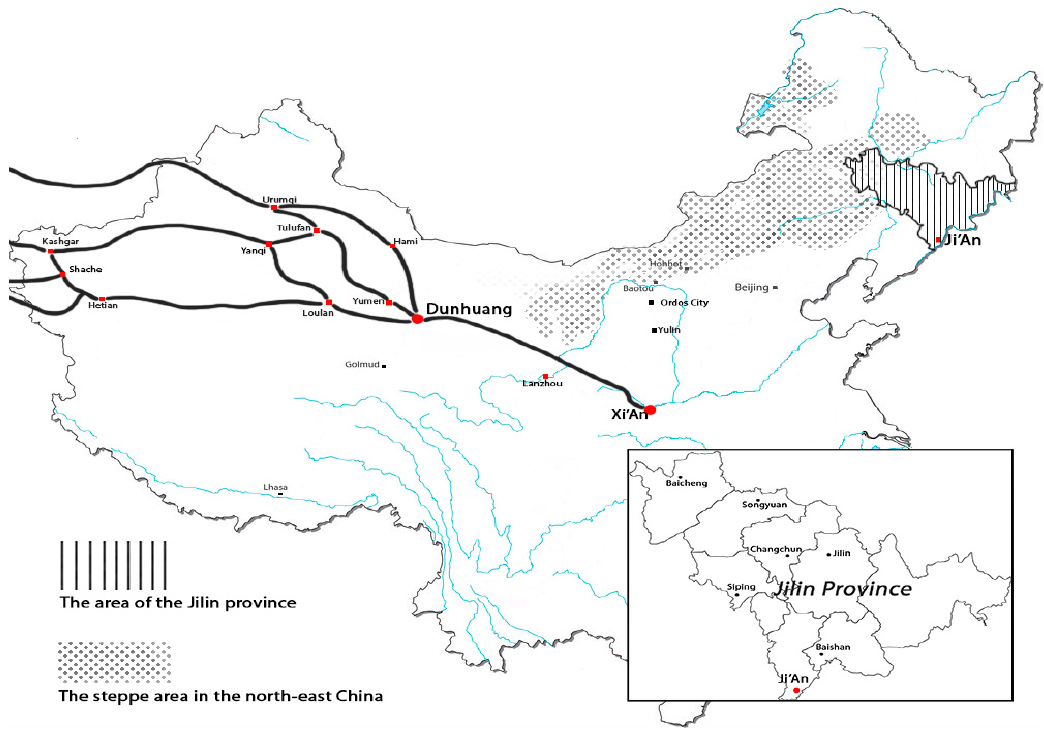
Figure 28. Jilin province and the Ji’An